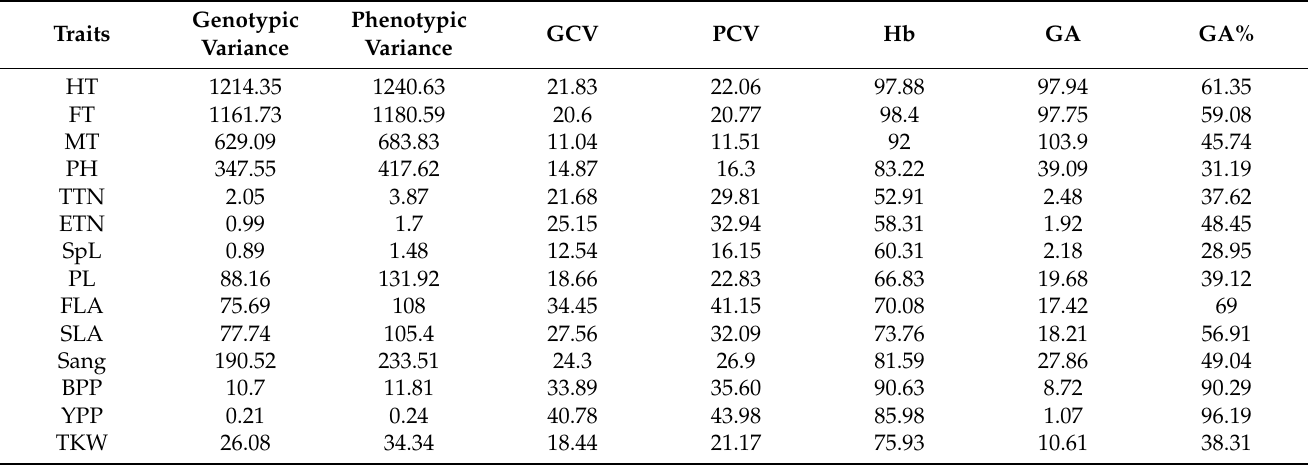
Table 2. Genetic diversity parameters for 19 aboveground traits of wild emmer